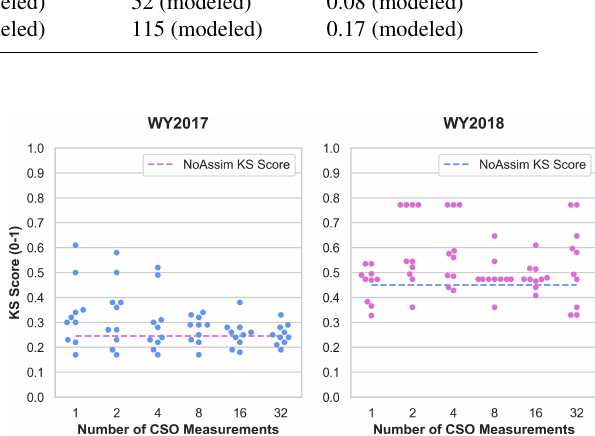
Figure 12. Swarm plots of Kolmogorov–Smirnov scores with pre- cipitation adjustment factor. The ensemble simulations are ranked by Kolmogorov–Smirnov (KS) score per water year (WY) and plot- ted according to the number of CSO measurements assimilated, in- cluding the no assimilation (NoAssim)